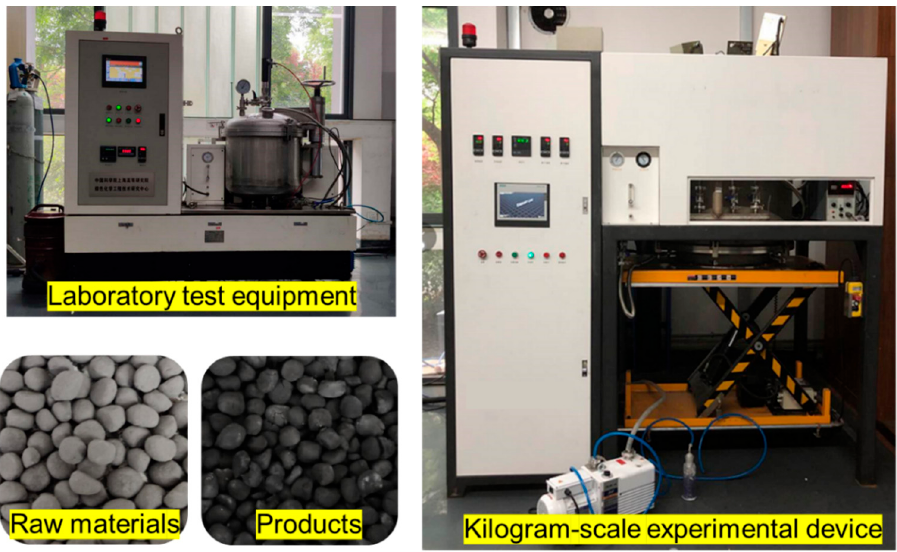
Figure 1. The MW heating equipment for CaC 2 synthesis.